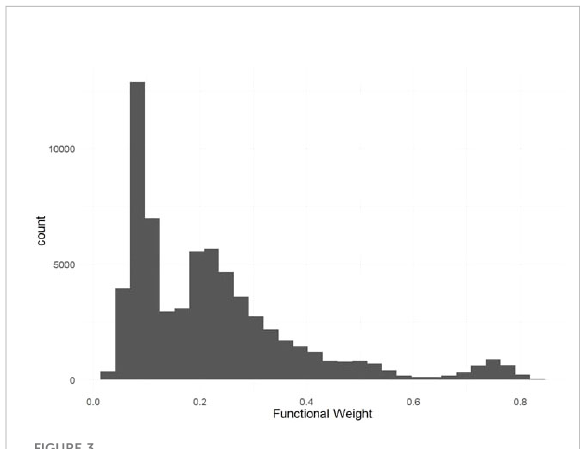
FIGURE 3 Predicted Functional Weights. Histogram of functional weights produced through RandomForest prediction of conservation for nonsynonymous variant sites. High functional weights correspond to highly conserved sites where nonsynonymous mutations are predicted to have large functional